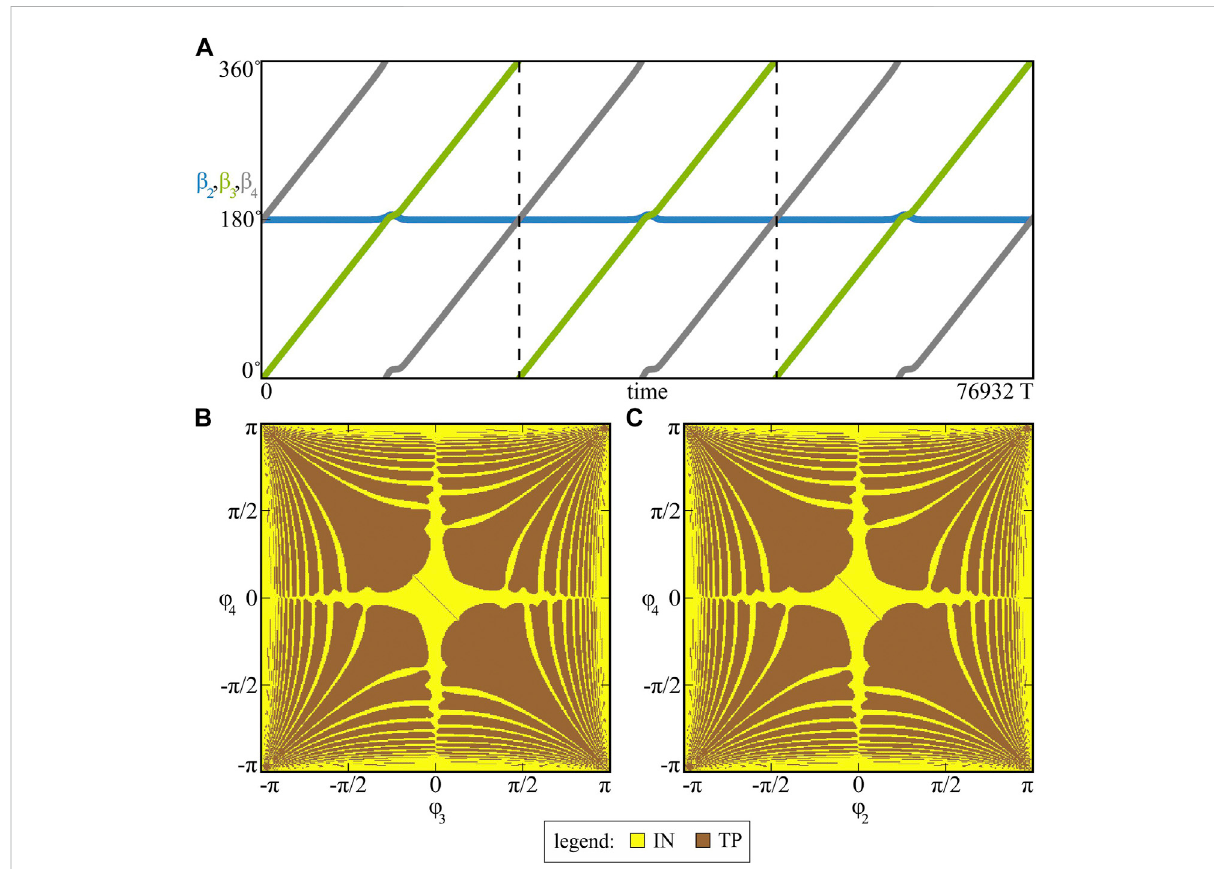
FIGURE 8 (Colour online). In (A) the traveling of phases β 2 , β 3 and β 4 for identical pendula m i = 1.0 [kg], i = 1, 2, 3, 4 is shown. The basins of attraction of possibledynamicalpatterns(INandTP)forvaried(